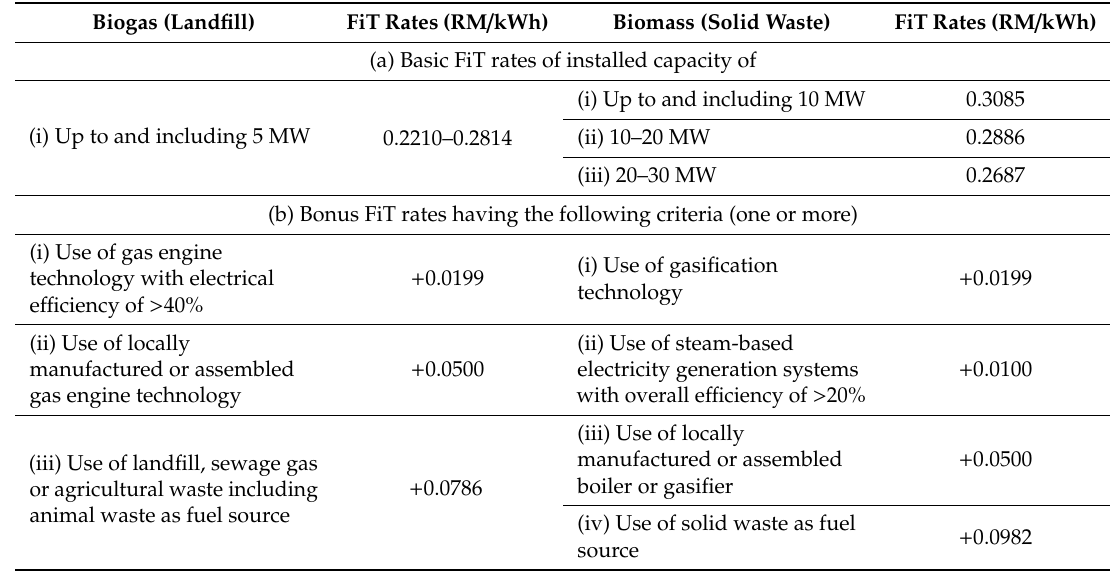
Table 9. The FiT rates for biogas and biomass as of 1 January 2019